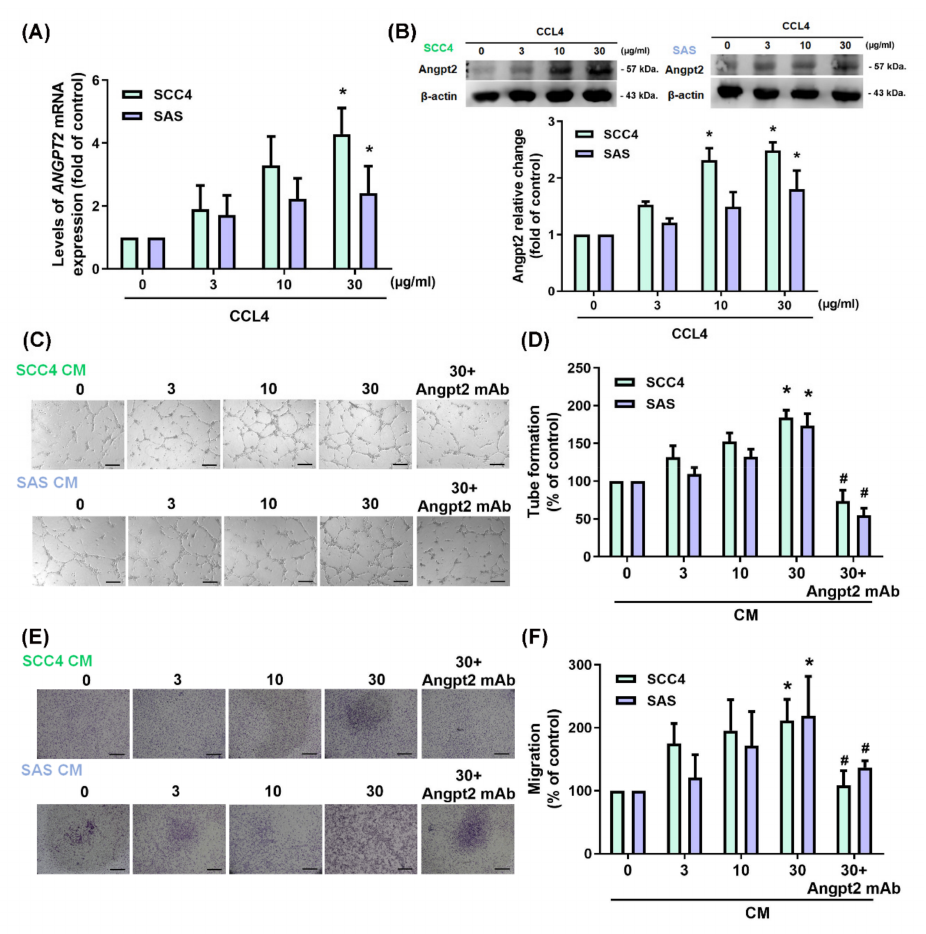
Figure 2. CCL4 increases Angpt2 expression and promotes angiogenesis in OSCC cells. ( A , B ) OSCC cells were treated with various concentrations of CCL4 protein (0–30 µ g/mL), then levels of ANGPT2 mRNA and protein expression were detected by qPCR and Western blot, respectively. ( C , D ) OSCC cells were treated with various concentrations of CCL4 (0–30 µ g/mL) for 24 h. Culture medium was collected as CM and applied to EPCs for 16 h. The capillary-like structure formation was examined by the tube formation assay. Scale bar, 100 µ m. ( E , F ) OSCC cells were treated with various concentrations of CCL4 (0–30 µ g/mL) for 24 h. CM was applied to the EPCs for 24 h. EPC migration ability was examined by the Transwell migration assay. Scale bar, 50 µ m. Each experiment was performed three times. * p < 0.05 compared with controls.; # p < 0.05 compared with the CCL4-treated group (30 µ